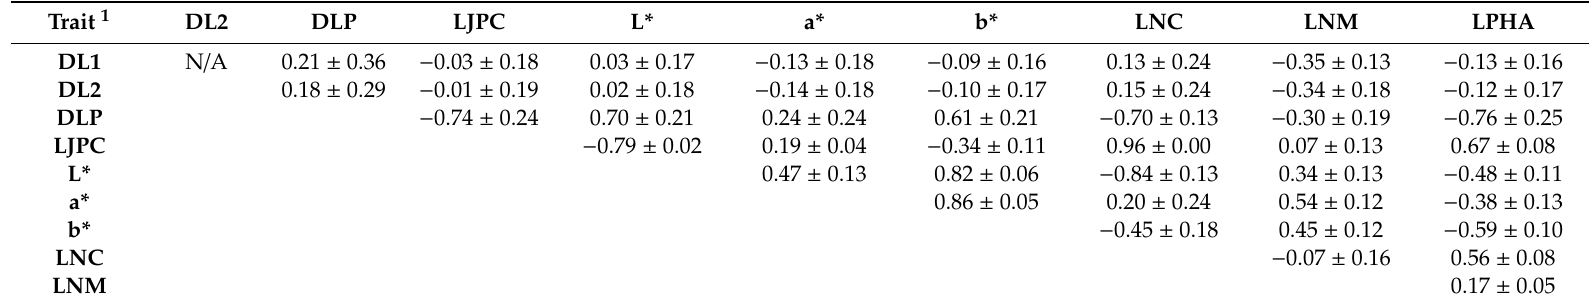
Table 12. Genetic correlations among pork quality